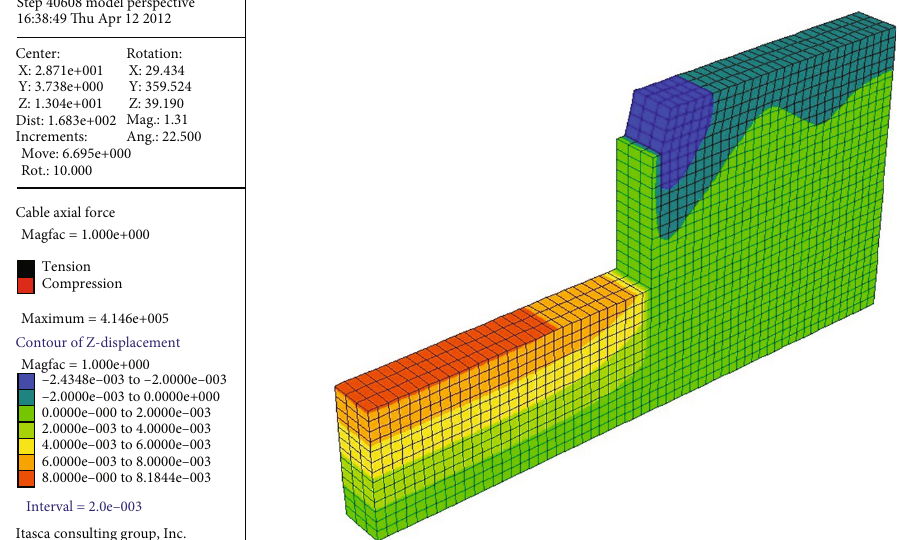
the excavation, the displacement of the pile top is relatively large at the initial stage of the excavation, and the position of the maximum horizontal displacement at the end of the excavation gradually moves down to a position of about 4 meters below the pile top. Comparing Figure 7(a): horizon- tal displacement of the west side of pit foundation with Figure 7(b): horizontal displacement of the simulated body of foundation, it can be seen that the variation trends of the measured curve value, the simulated curve, and the design curve of the deep horizontal displacement of the pile are consistent, and the maximum horizontal displace- ment is located in the middle of the pile. As the horizontal displacement increases during the excavation, the displace- ment of the pile top is relatively large at the initial stage of excavation; at the end of the excavation, the maximum horizontal displacement position gradually moves down to about 4 meters below the pile top. A comparison of hor- izontal displacement monitoring and simulation results shows that the numerical model meets the veri fi cation requirements.